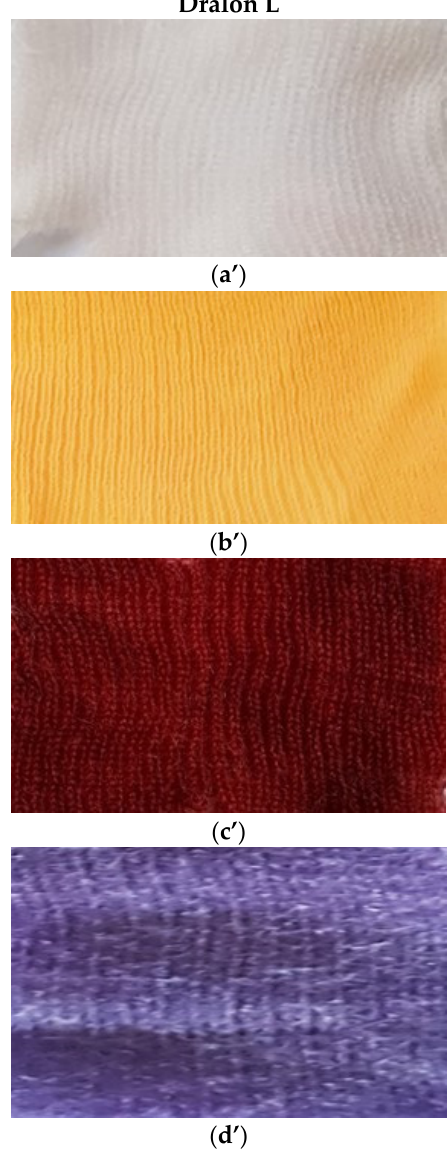
Figure 17. Color of acrylic fibers in different treatment stages: ( a , a’ ) untreated, ( b , b’ ) functionalized, and ( c – d’ ) functionalized and dyed with acid dyes (C.I. Acid Red 57 and C.I. Acid Violet 48). The functionalization of Melana and Dralon L fibers was confirmed by: